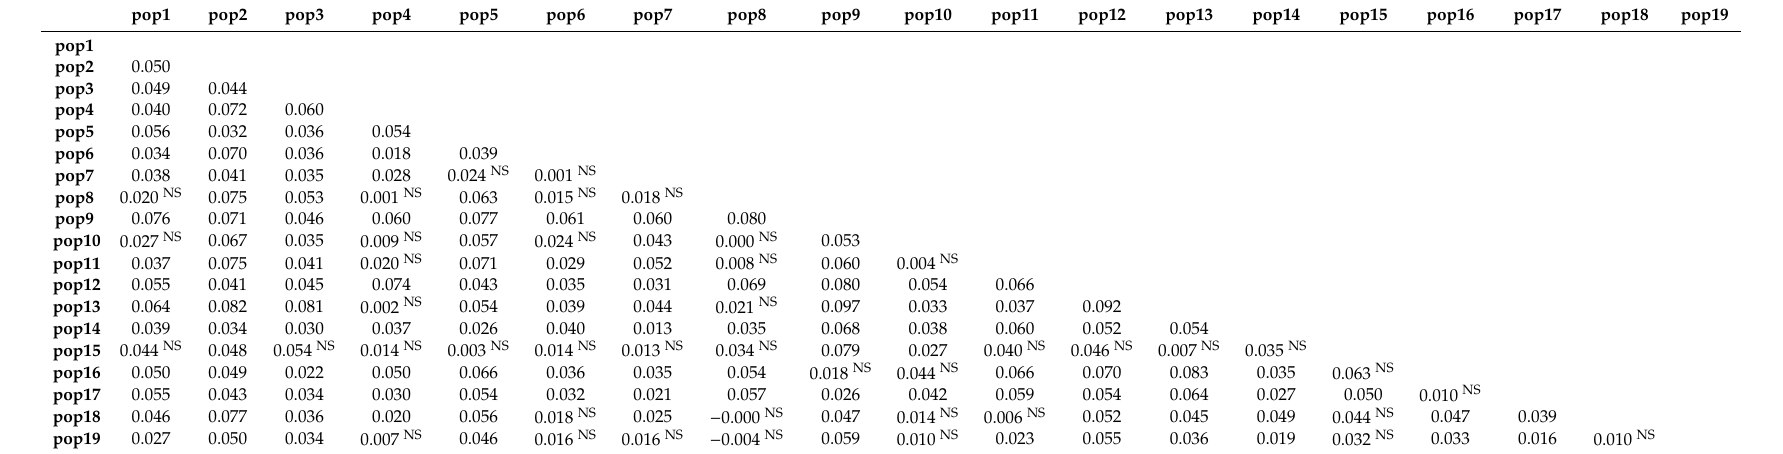
Table 4. Pairwise comparisons of fixation index ( F ST ) between each pair of populations. Only one copy per multilocus genotype (MLG) was considered for computing the F ST